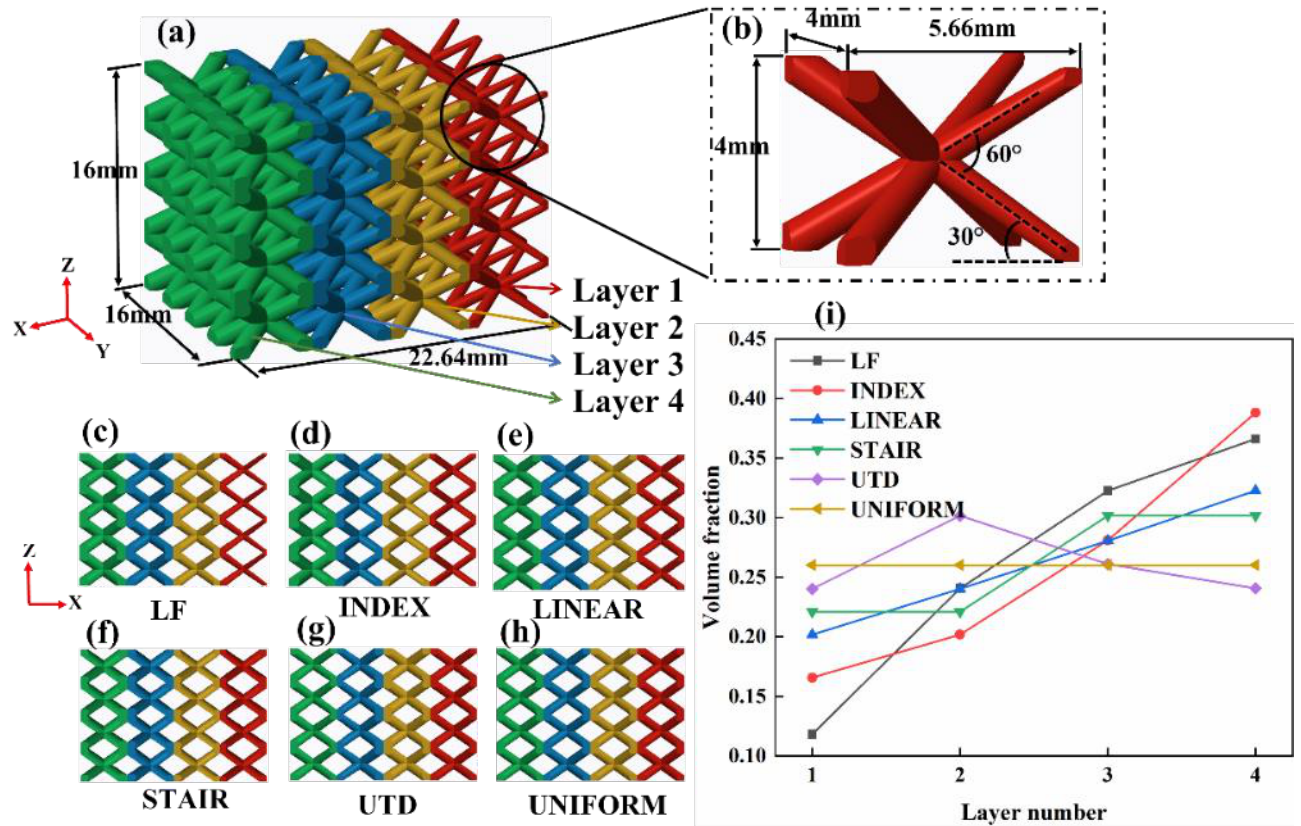
Figure 1. CAD-based configuration and geometry of the lattice structure ( a ) and unit cell ( b ), the front view of each lattice structure for different density gradients ( c – h ), and the volume fraction profiles corresponding to different layers of the lattice structure with different density gradients ( i ).